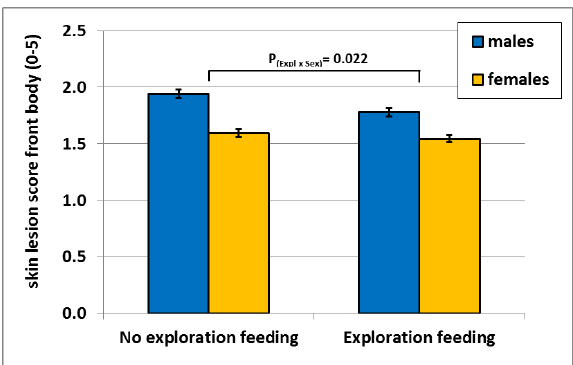
Figure 2. Mean front skin lesion score per treatment (exploration feeding) and sex with SEM.